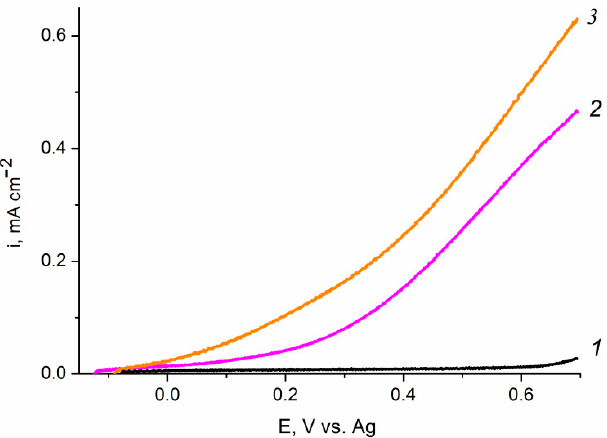
Figure 10. Polarization curves of a Ti 4+ /Fe 2 O 3 /FTO film photoanode measured: (1) in dark condi- tions, and (2, 3) under visible light illumination with a power density of 100 mW cm − 2 in aqueous solutions of 0.1 M KOH and 0.1 M KOH + 0.01 mM 5,6,7,8-tetrahydro-2-naphthol, respectively.